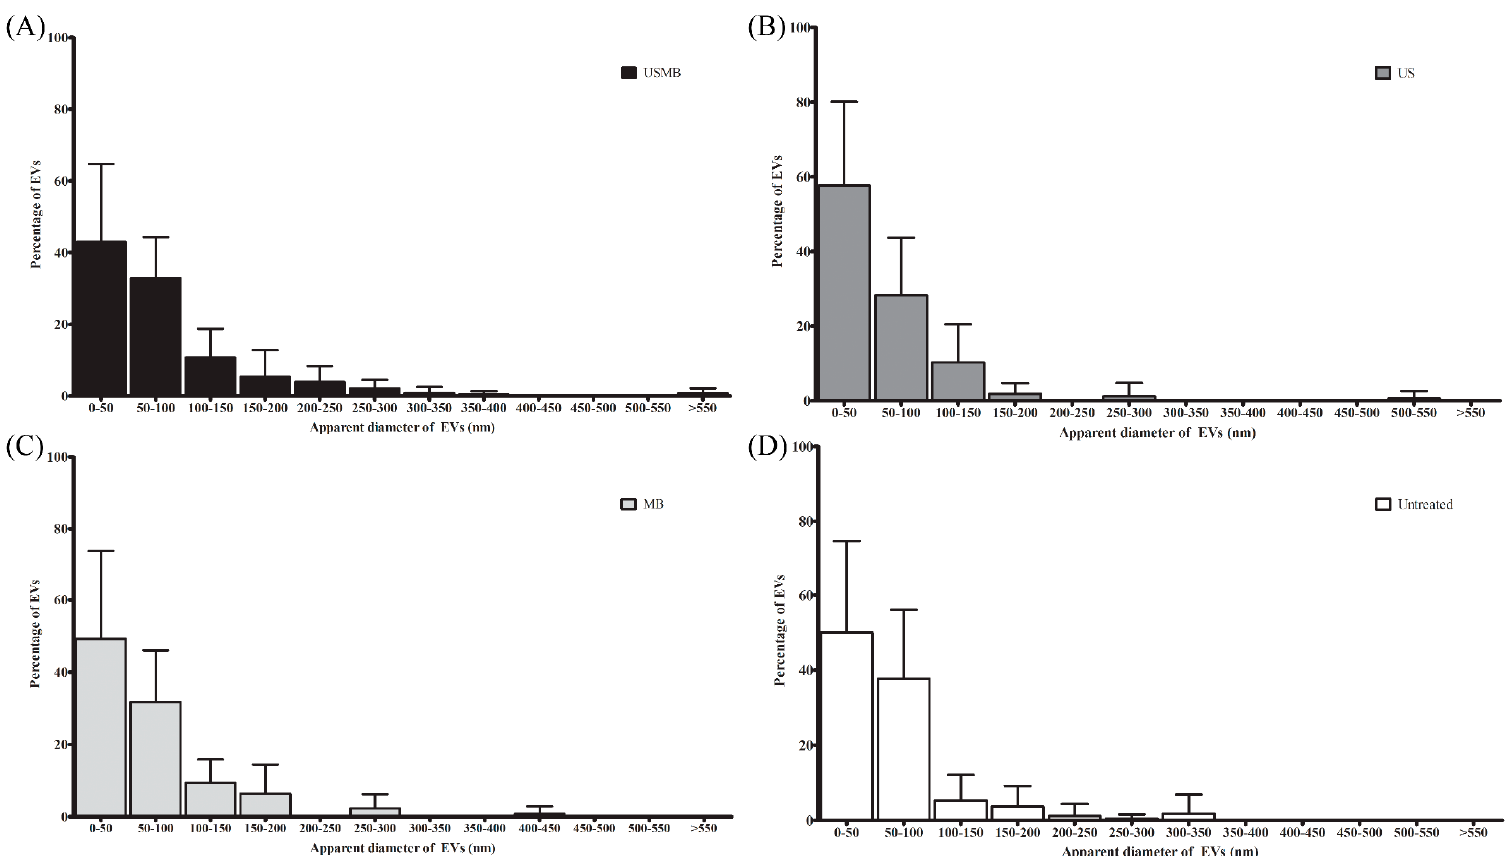
Figure 4. Size distribution of EVs detected in conditioned media collected at 4 h from cells after microbubbles-assisted ultrasound (USMB, A ), ultrasound (US, B ), or microbubbles (MB, C ) treatments, and from untreated cells ( D ). Surface area of EVs was measured using Image J [20] to calculate the apparent diameter of EV (nm). Bin size is 50 nm. EVs were detected from 10 images per grid (60,000× magnification) derived from four independent experiments. Percentage of EVs represents the percentage of mean of EVs at certain size range + standard deviation.